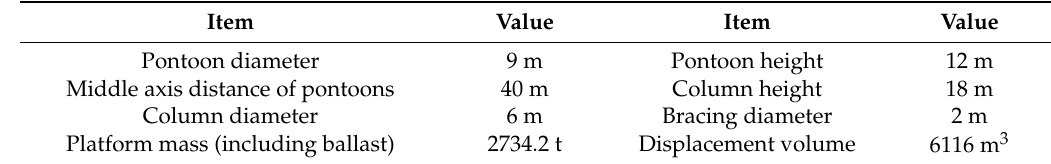
Table 2. Floating platform principal properties.